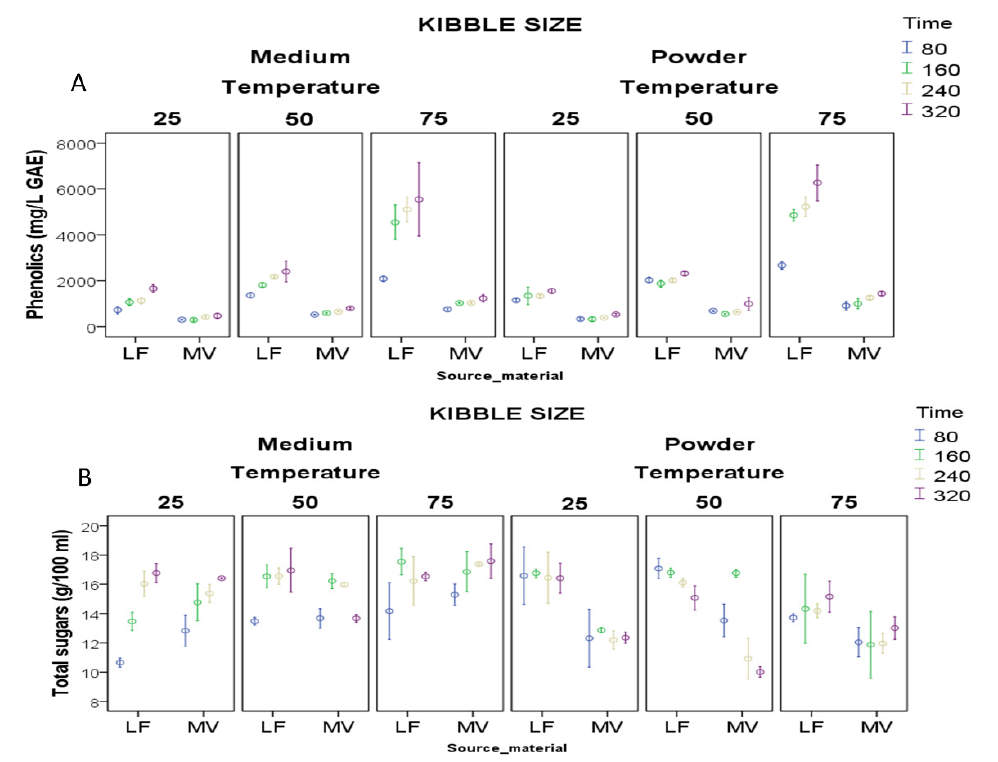
Figure 1. Interaction plots for total phenolics and sugars obtained by heat-assisted extraction (HAE; ( A , B )) of different source materials (LF: Lefkaritiki; MV: Mavroteratsia) and kibble sizes (medium and powder). HAE extraction varied in time (80, 160, 240, 320 min) and temperature (25, 50, and 75 °C). Data points represent means of three replicates with standard error bars.